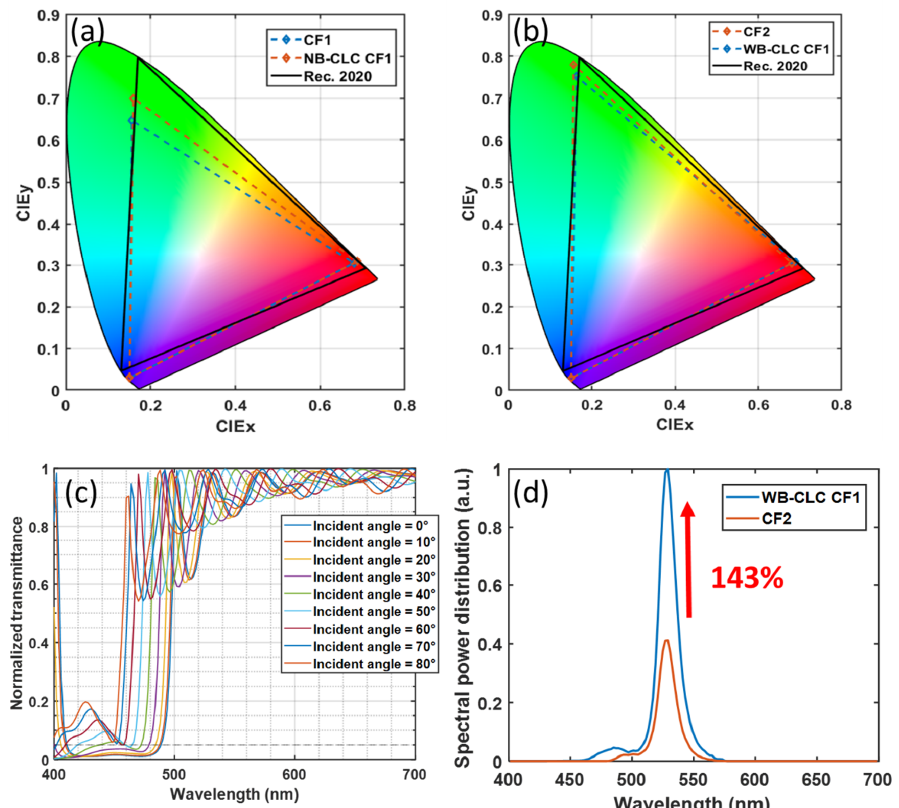
Figure 7. ( a ) Simulated color gamut for display systems with CF1 only, and with CF1 and narrowband CLC film. ( b ) Simulated color gamut for display systems with CF2 only, and with CF1 and wideband CLC film. ( c ) Reflection spectra of planar texture wide band CLC (WB-CLC) film at different incident angles. ( d ) Comparison of the spectral power distribution of green sub-pixel between display systems with CF2 only, and with CF1 and wideband CLC film.